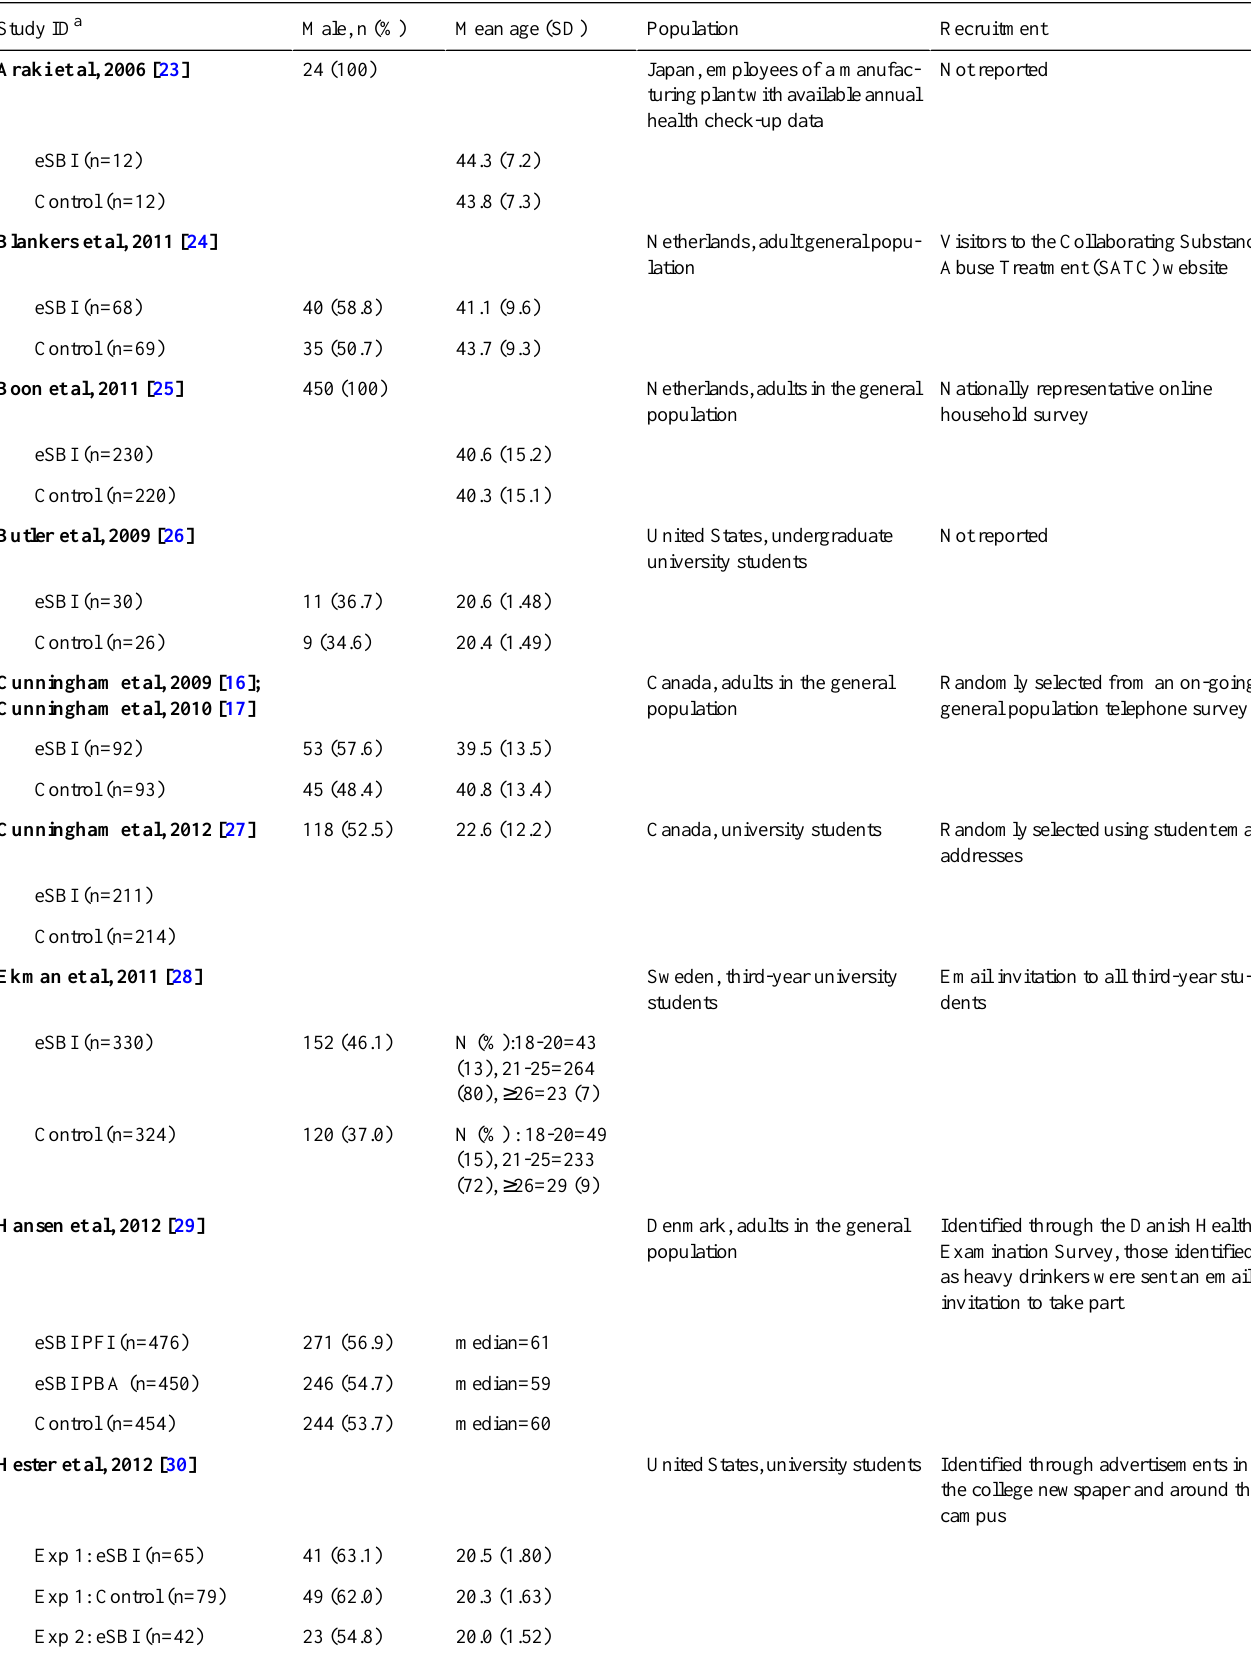
Table 2. Size and nature of study population and method of